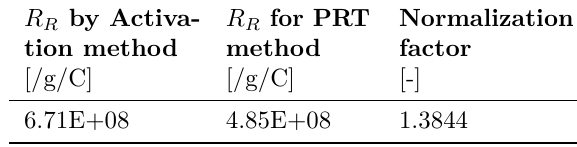
The reaction rates calculated for 89 Y(n,2n) 88 Y reaction and their